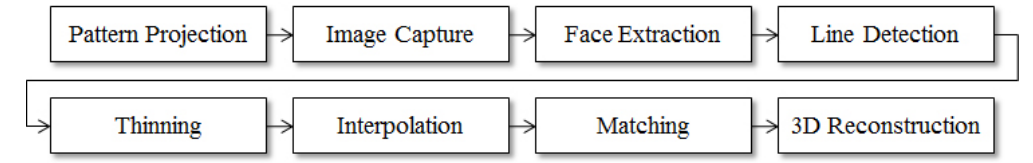
Figure 4. On-line process for 3D face